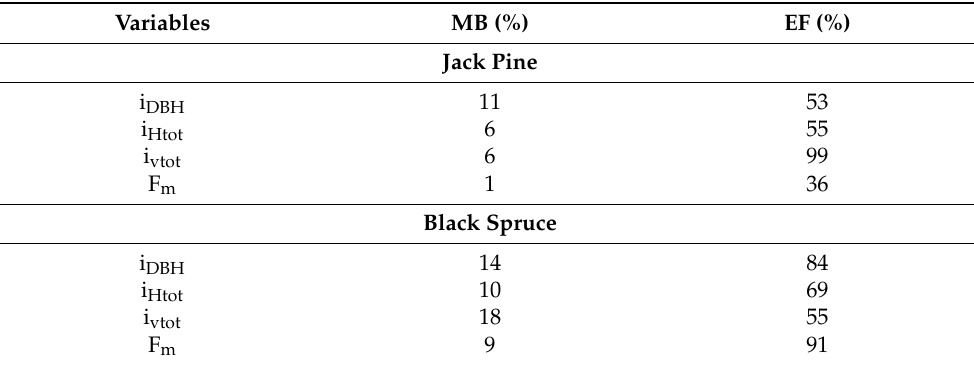
Table 3. Jack pine and black spruce average model bias (MB) and efficiency (EF) for yearly diameter increment at 1.30 m (i DBH ), tree height (i Htot ), yearly stem volume increment (i vtot ), and total tree foliage biomass (F m